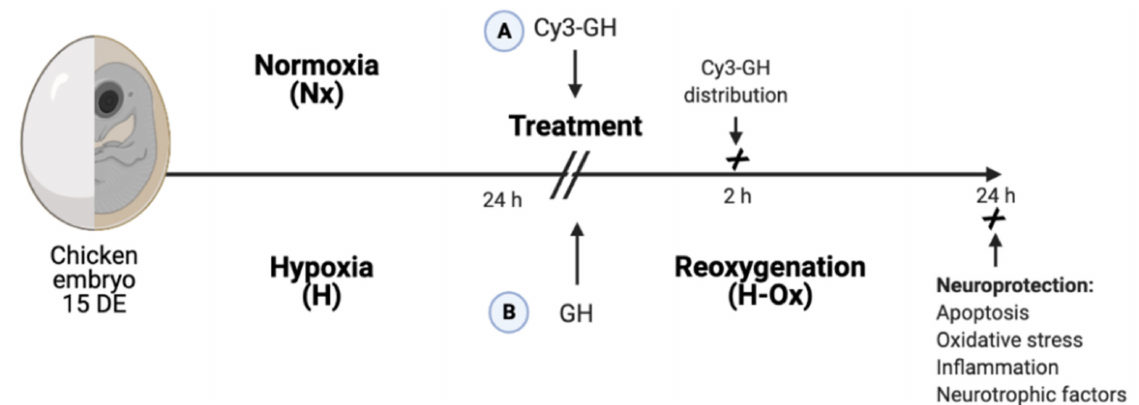
Figure 1. Experimental design. Initially, 15-day old chicken embryos were exposed to either normoxia or hypoxia (by wrapping half of the eggshell with a polyvinyl membrane) for 24 h, at 39 ◦ C. Then, two approaches were followed: ( A ) Cy3-GH (0.15 µ g/g) was microinjected in the chorio-allantoid vein, and 2 h later, the distribution of the fluorescent hormone and its integrity were evaluated in several brain regions and in the liver by histochemistry and Western blot; ( B ) embryos were treated with recombinant chicken GH (0.15 µ g/g) and were submitted to re-oxygenation for another 24 h, and its effects upon apoptosis (caspase-3 and TUNEL assay), oxidative stress (lipid peroxidation), and expression of inflammatory mediators and neurotrophic factors were